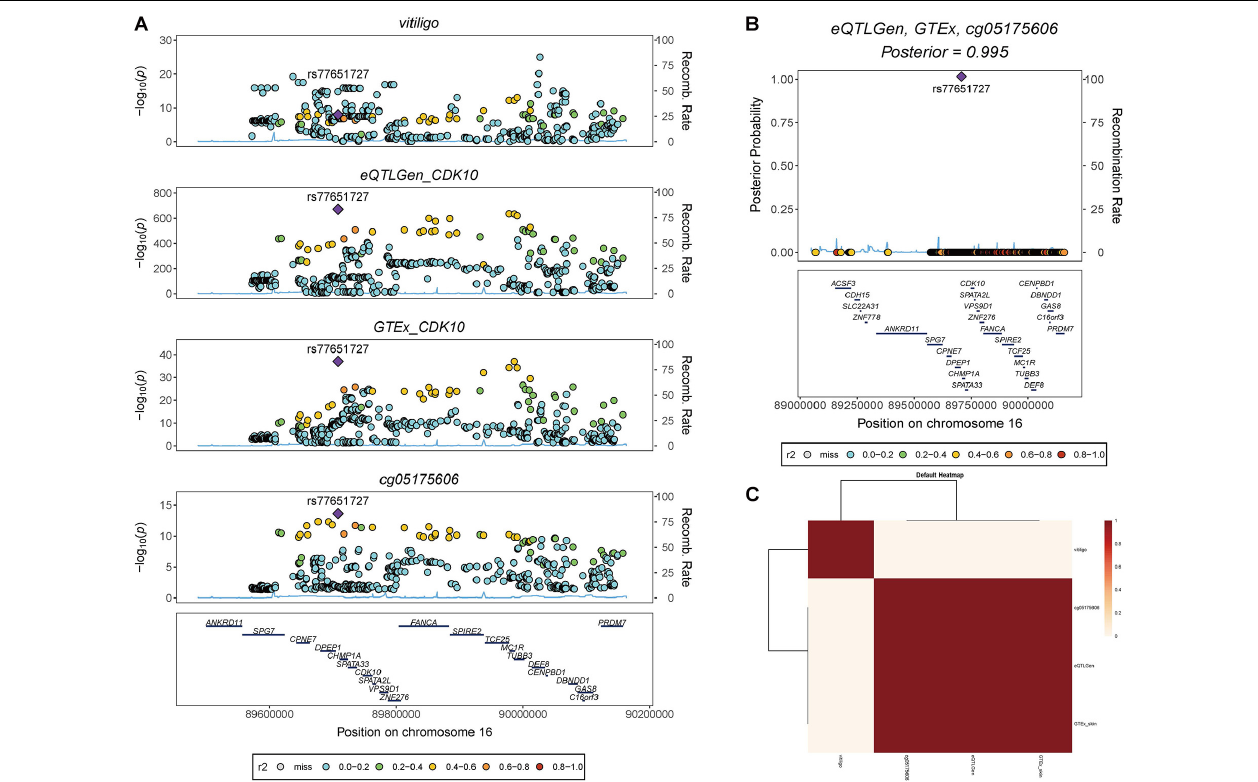
FIGURE 4 | Colocalization analysis of vitiligo, transcript of CDk10 , and cg05175606. (A) Stacked association plots of vitiligo with the transcript of CDK10 in eQTLGen and GTEx sun-exposed skin eQTL data, and cg05175606 in meQTL data. HyPrColoc detected rs77651727 is the top-associated variant in eQTL and meQTL data. The variant is also associated with vitiligo at a genome-wide significant level. (B) HyPrColoc identified rs77651727 as a candidate causal variant explaining the shared association signal between the transcript of CDK10 and cg05175606, i.e., rs77651727 explained 100% of the posterior probability of